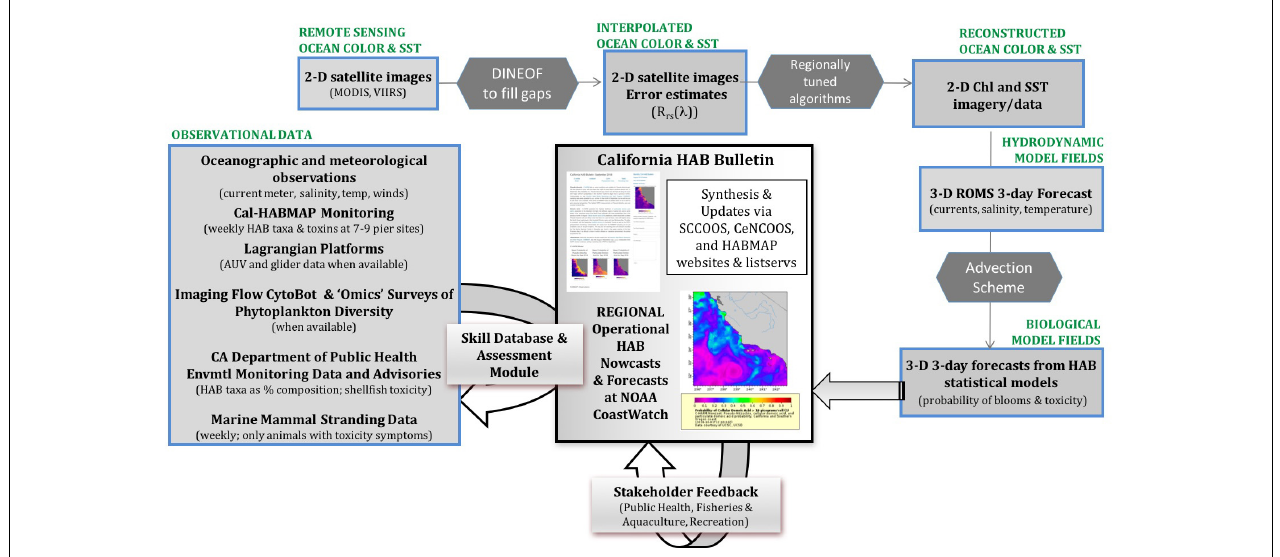
FIGURE 2 | An integrative schematic of the in situ data sets, remote sensing imagery, and model output that support production of the C-HARM system for blooms and domoic acid events. Stakeholder engagement is conducted via the monthly CA HAB Bulletin. Modified from Anderson et al.